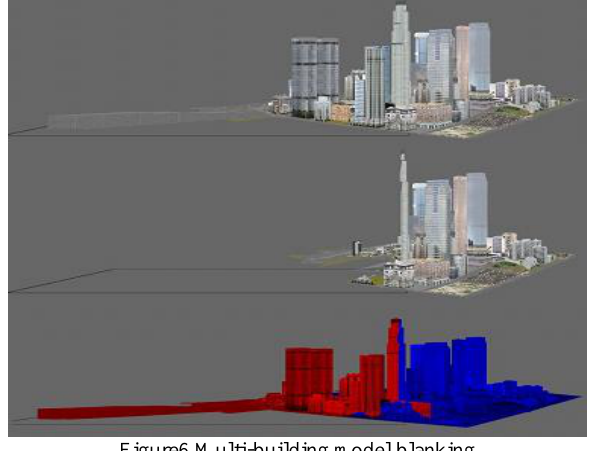
Figure6 Multi-building model